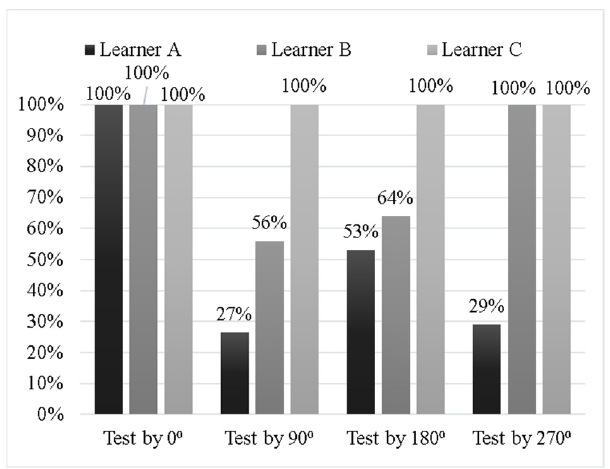
Figure 5. Accuracy of determination over seven classes for Learners A, B, and C by each testing image.